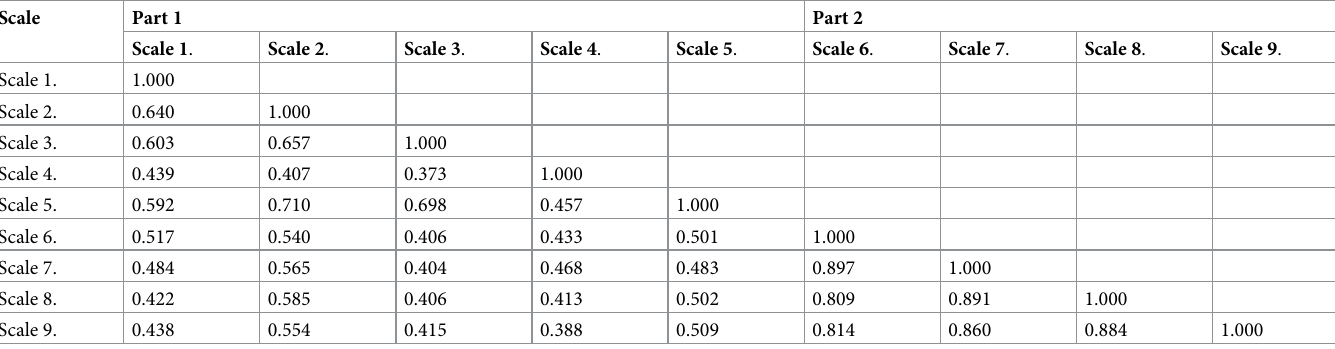
Table 3. Inter-factor correlations among the nine scales (n =